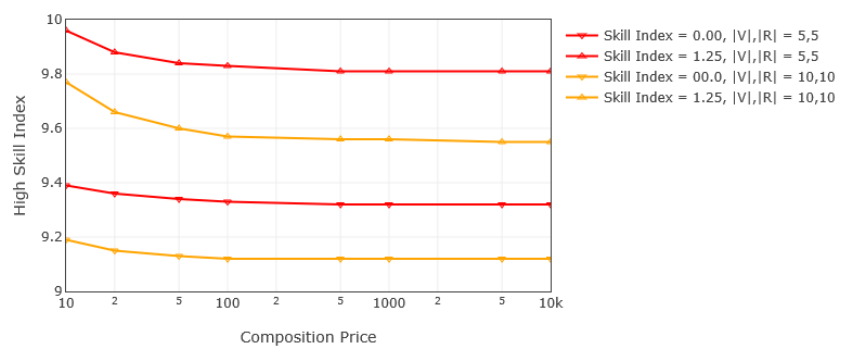
Figure 6. Skill Indices for 16:1 estimate ratios by price.